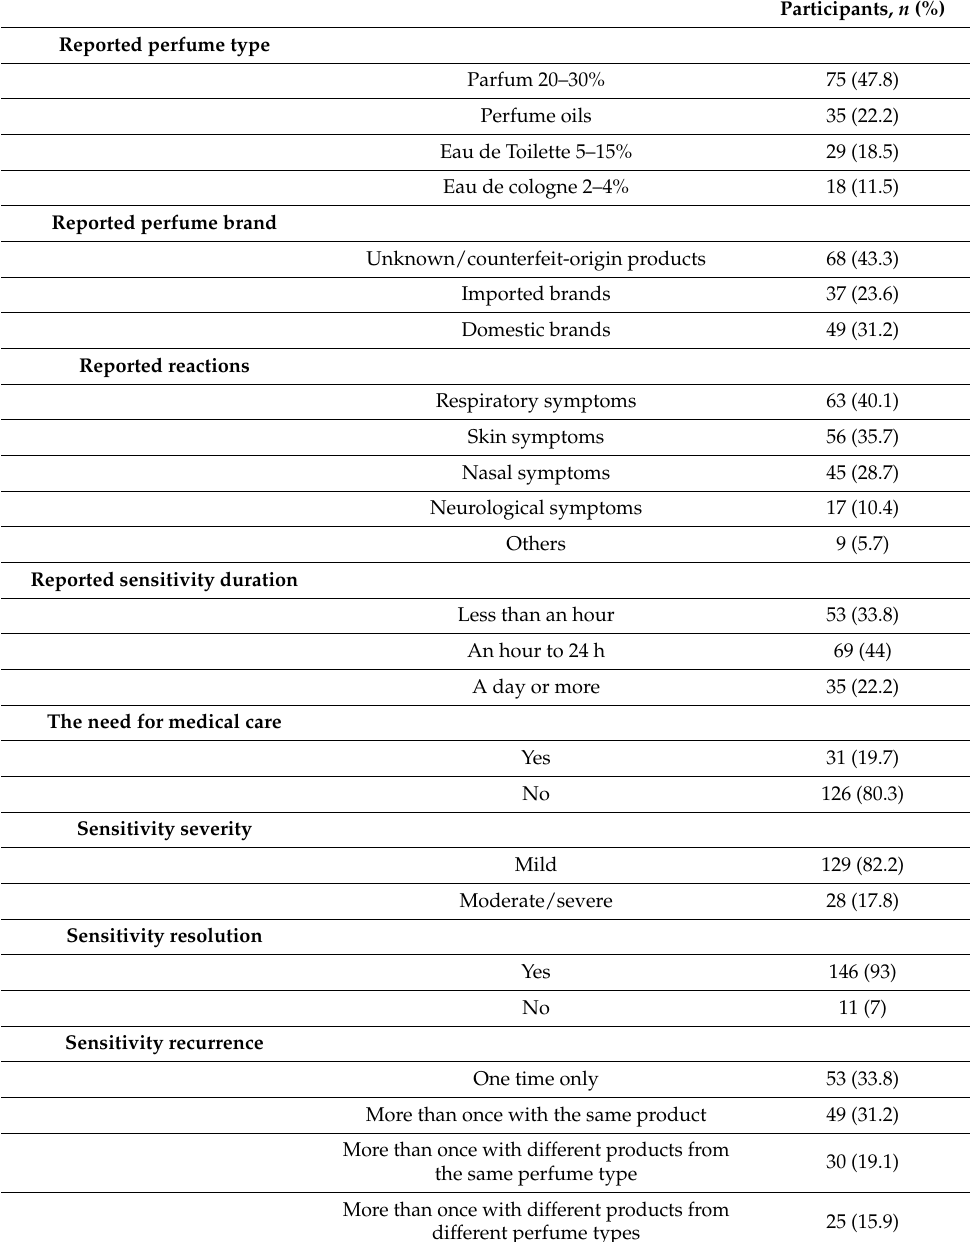
Table 2. Self-reported perfume sensitivity among study participants ( n =